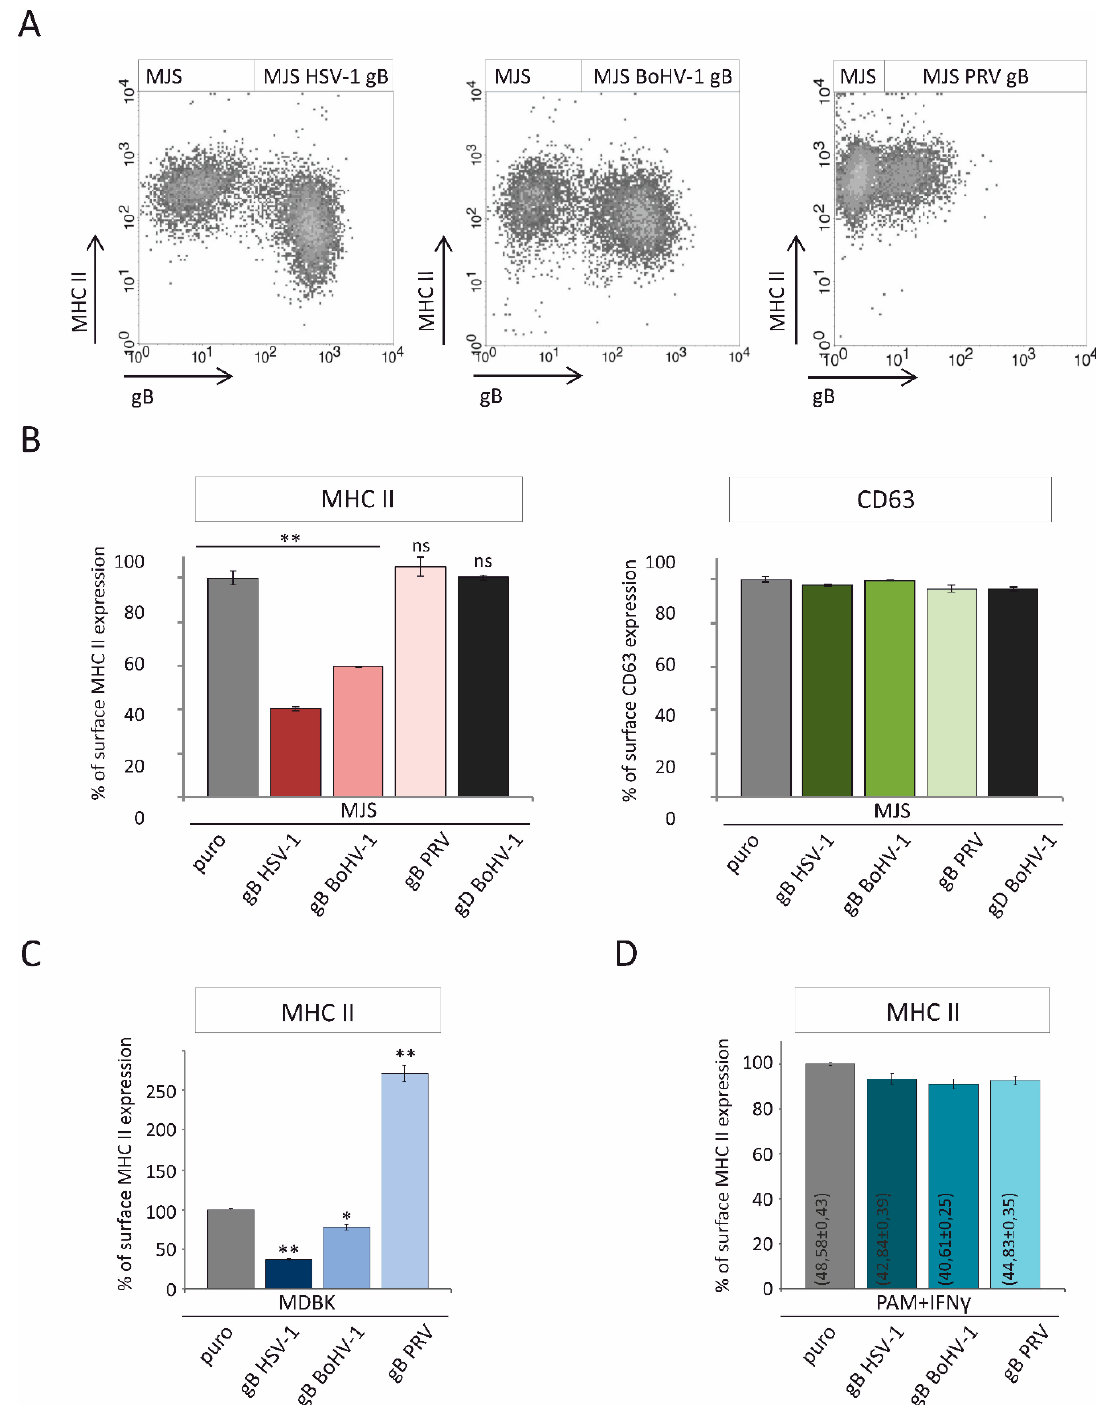
Figure 4. The e ff ect of alphaherpesvirus gB expression on the surface levels of human, bovine, and porcine MHC class II. ( A ) Surface expression of HLA-DR was assessed by flow cytometry on gB-retrovirus transduced unsorted MJS cells (a nerve growth factor receptor (NGFR) marker reflecting gB expression is plotted against MHC II). ( B ) Analysis of the relative HLA-DR levels on the surface of gB-expressing sorted cells. Surface CD63 expression was analyzed as a control. The e ff ect of the BoHV-1-encoded gD on surface MHC II and CD63 was assessed for comparison. The mean